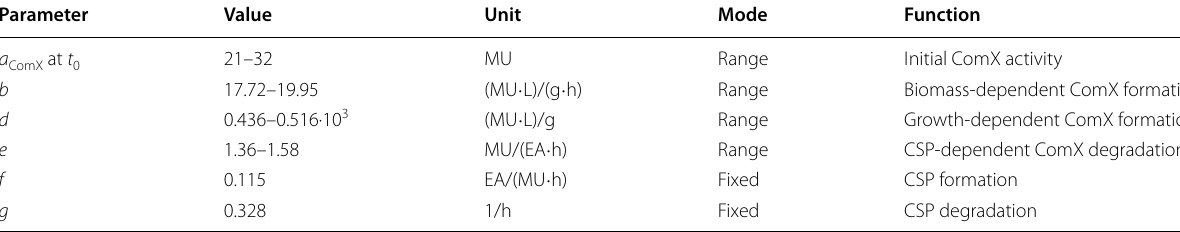
Table 2 List of parameter values, units and description used for modeling Parameter Value